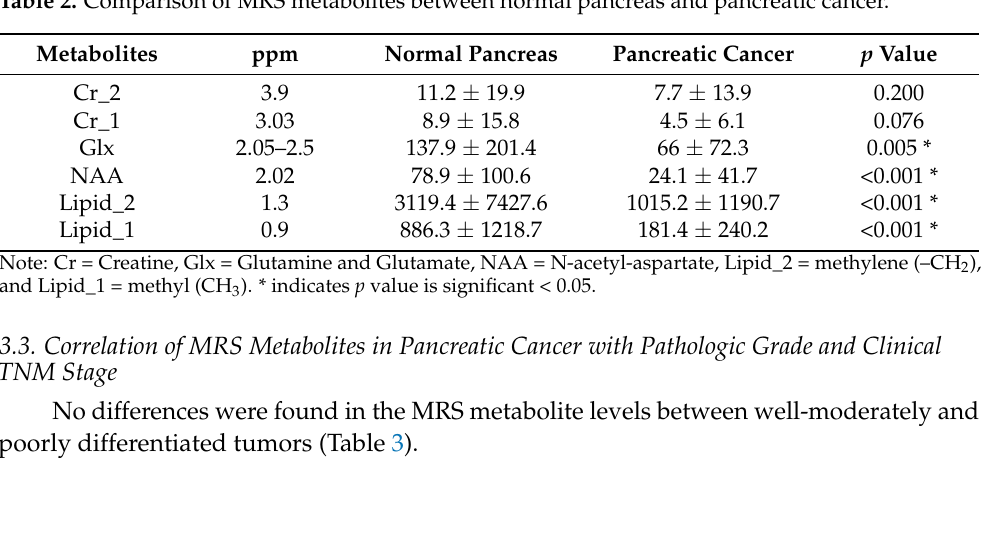
Table 2. Comparison of MRS metabolites between normal pancreas and pancreatic